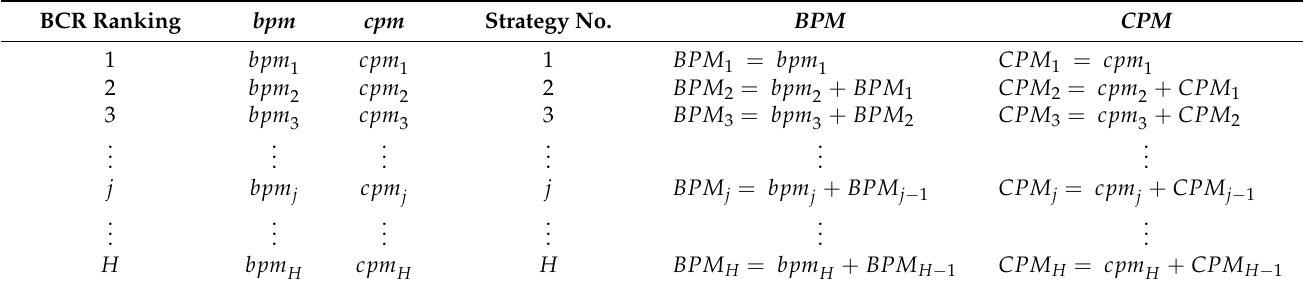
Table 6. BPM j and CPM j generated for strategy j from j = 1 to H